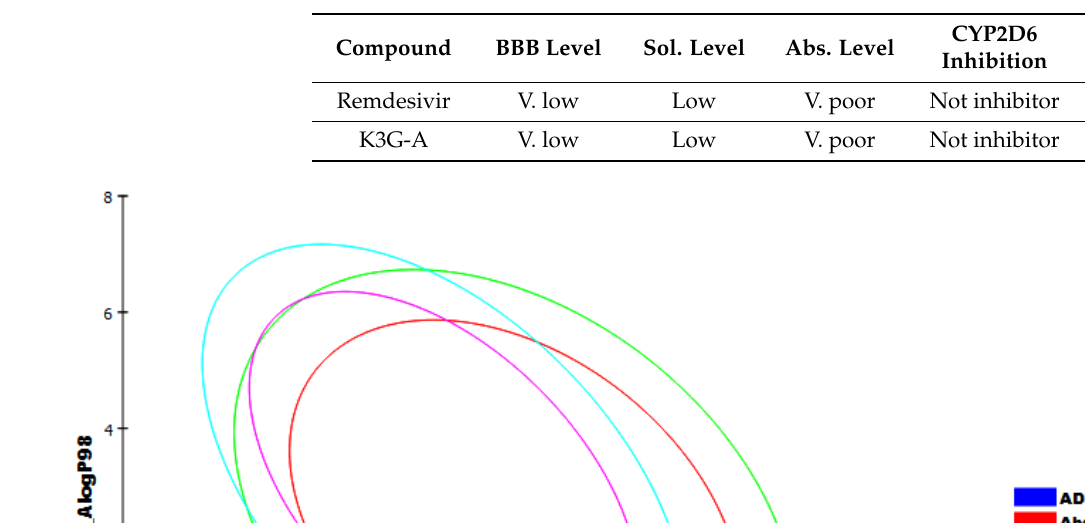
Table 4. Predicted ADMET for K3G-A and remdesivir.